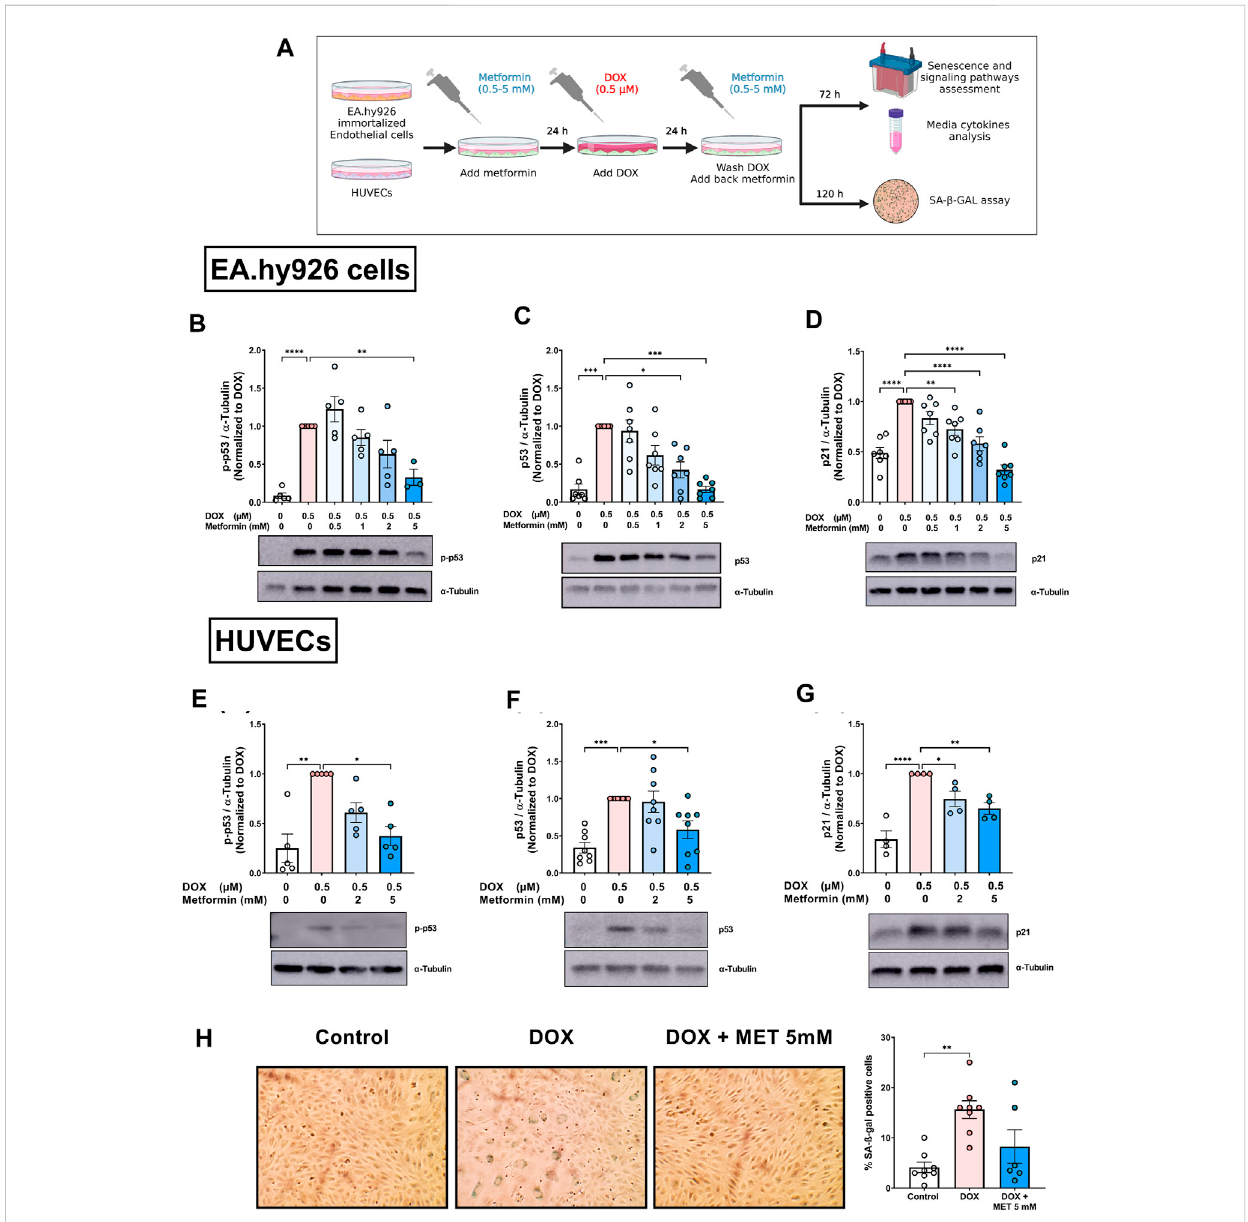
FIGURE 1 Metformin inhibited DOX-induced upregulation of senescence markers and SA- β -gal activity in endothelial cells. (A) Schematic diagram of the experimental design. Both EA.hy926 endothelial derived cells and HUVECs were treated for 24 h with 0.5 µM DOX ± metformin (0.5 – 5 mM, added 24 h beforeDOX).Thereafter,DOXwasremovedandthecellswereincubated inDOX-freemediawithorwithoutmetforminfor anadditional72 hfor protein expression experiments or 120 h for measurement of SA- β -gal staining. Expression levels of senescence markers including p-p53, p53, and p21 in EA.hy926 cells (B – D), and HUVECs [ (E – G) , respectively] weremeasuredusingwesternblot(n =4 – 8).Representativeimagesofwesternblotsare shown. Values were normalized to α -tubulinand expressedrelative to cells treated with DOX alone. (H) Images ofSA- β -gal staining incontrol,DOX-treated, and DOX+ metformin co-treated cells are shown inHUVECs. Images were analyzed and thepercentage ofSA- β -gal positive cells werecalculated (n = 6 – 8). Values are presented as means ± SEM. Data were analyzed by one-way ANOVA followed by a Dunnet ’ s multiple comparisons test (Figures 1B,D,F – H)